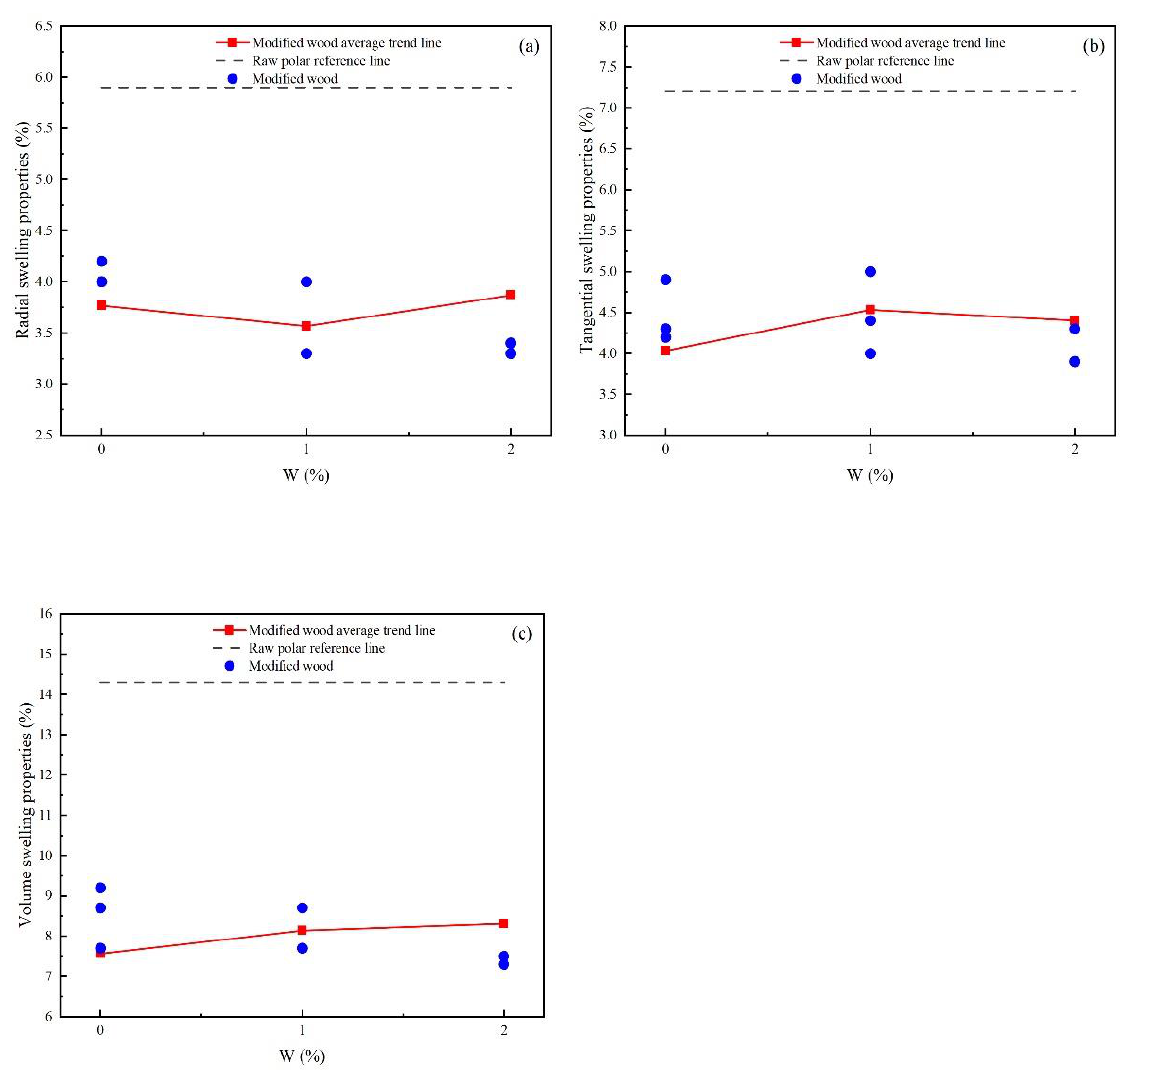
Figure 3. Comparative analysis of swelling properties of modified wood based on W: ( a ) radial swelling properties; ( b ) tangential swelling properties; ( c ) volume swelling properties.